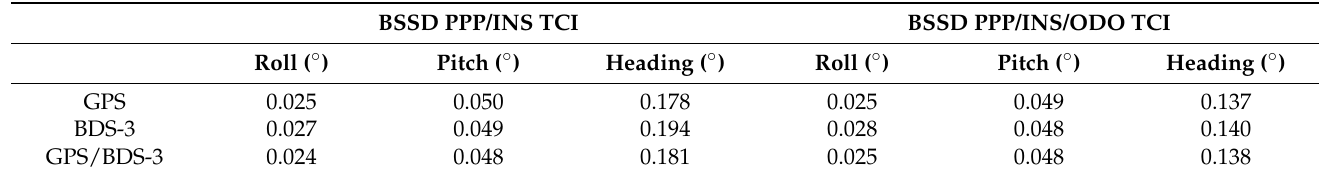
Figure 19. Attitude differences between BSSD PPP/INS TCI and BSSD PPP/INS/ODO with different GNSS.